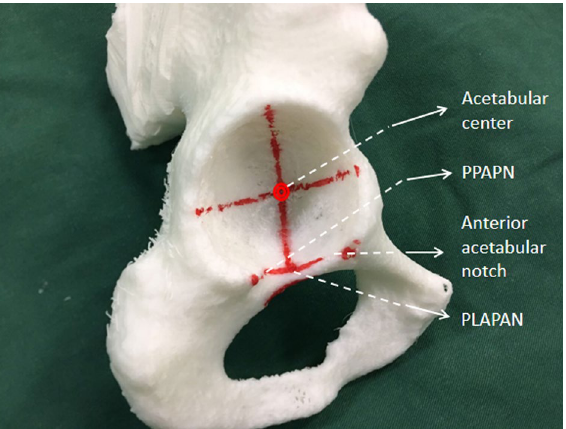
Figure 1. Acetabulum model and anatomical landmarks ( PPAPN proximal point of acetabular posterior notch, PLAPAN proximal line of the anterior and posterior acetabular notches).